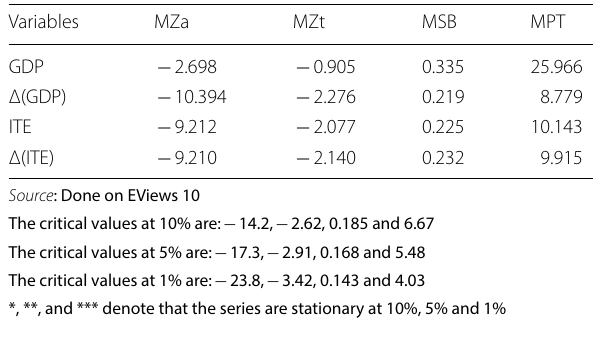
Table 2 Unit root test without structural breaks (Ng-Perron) for the model with the constant and linear trend